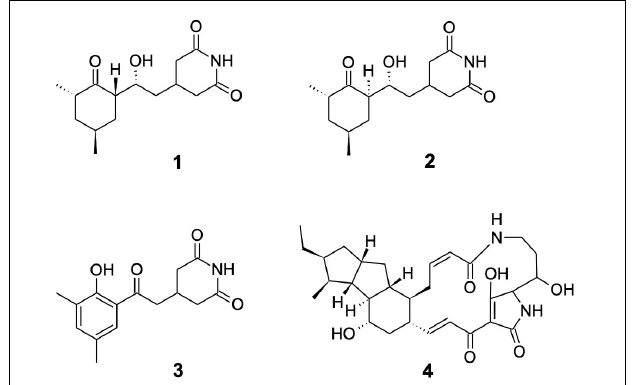
FIGURE 6 | Metabolites isolated from S. griseus XylebKG-1. Cycloheximide (1) ; naramycin B (2) ; actiphenol (3) ; and dihydromaltophilin (4) .